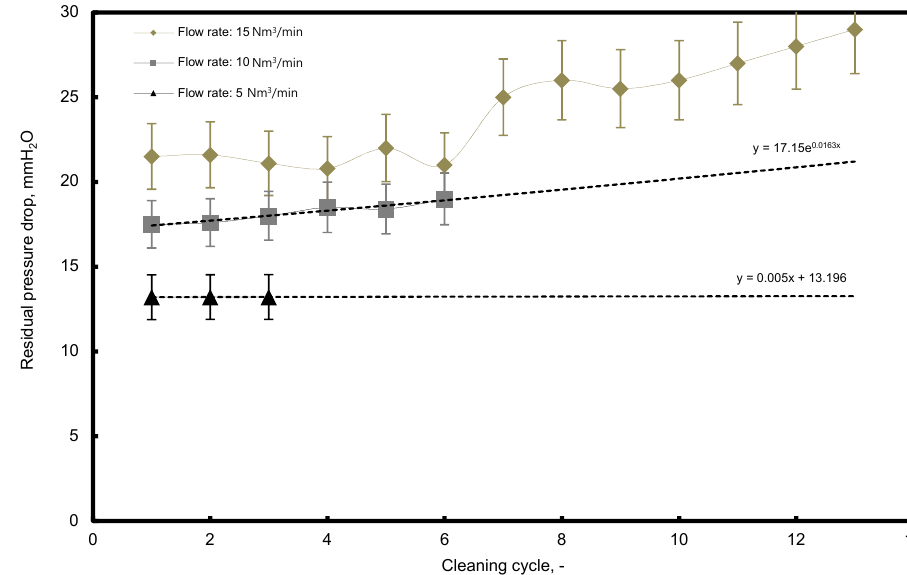
Figure 6. Residual pressure drop trend with flow rate variable.